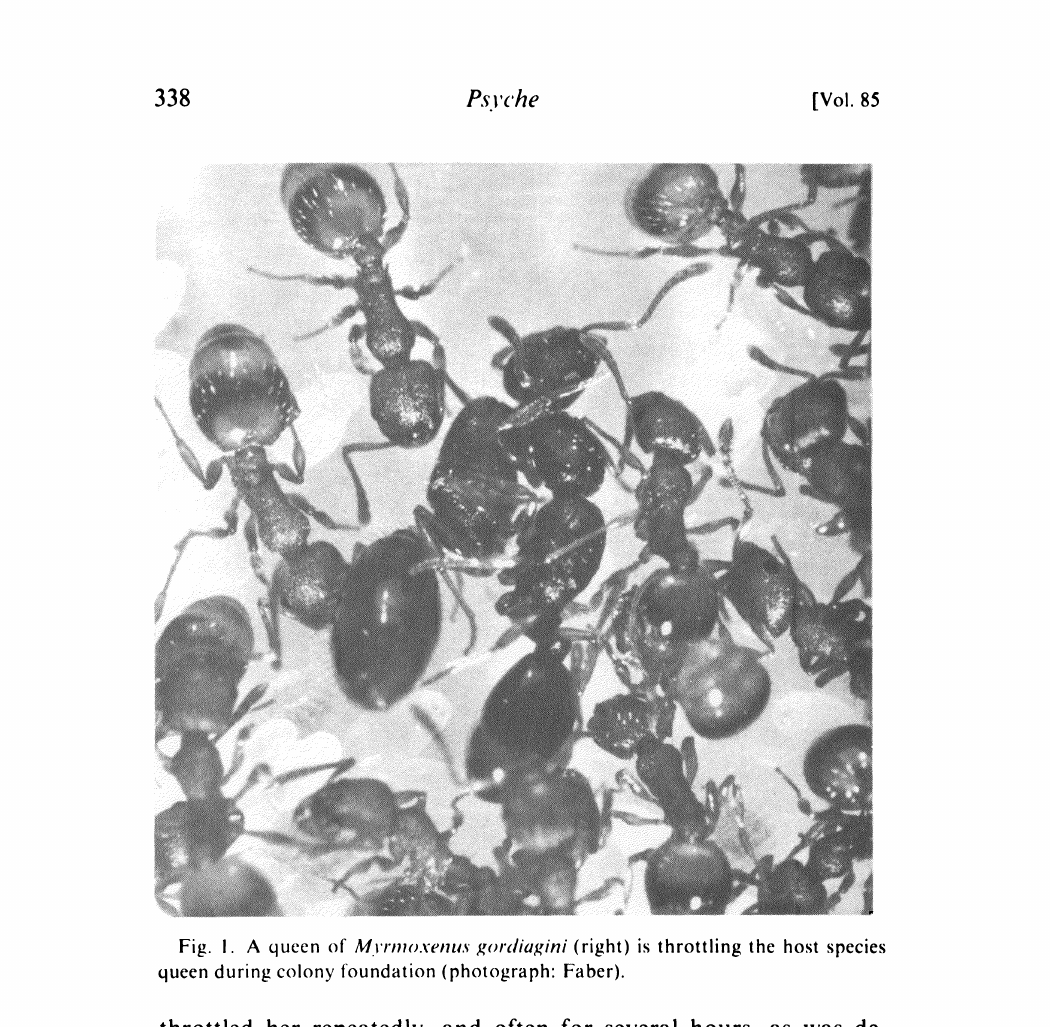
Fig. I. A queen of M’roloxenu,’ gordiagini (right) is throttling the host species queen during colony foundation (photograph: